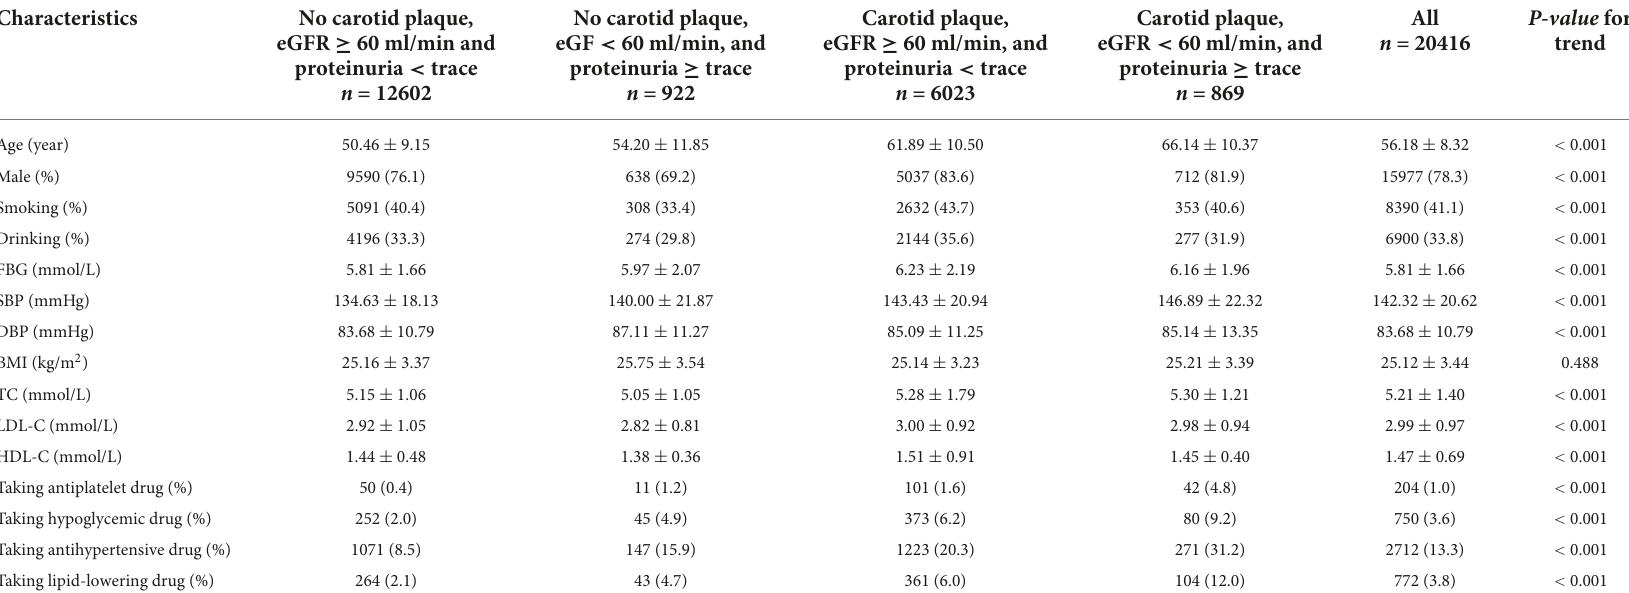
TABLE 1 Baseline characteristics of the study population.